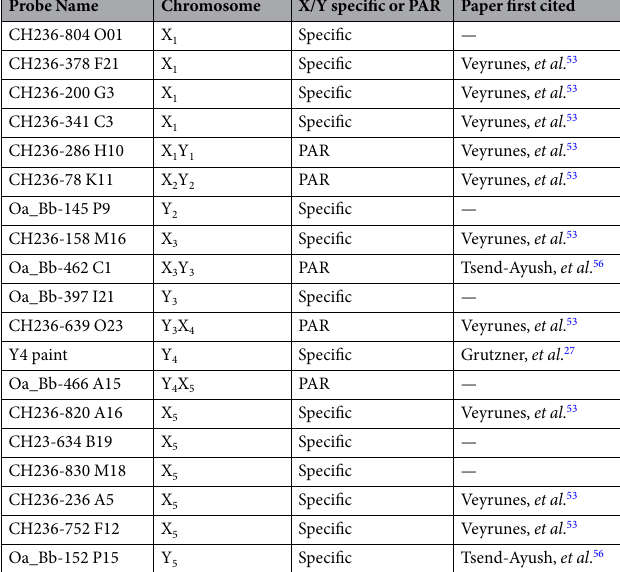
Differential SMC3 loading on paired and unpaired regions of platypus sex chromosomes at prophase I. To better characterise the sex chromosome specific SMC3 accumulations we immunostained for SMC3 in combination with DNA FISH using a selection of BACs and chromosome painting probes targeting XY specific and XY shared (PAR) regions. After SMC3 immunostaining, imaged cell coordinates were recorded prior to a series of DNA FISH experiments using combinations of X 1 pooled, X 4 , Y 5 and pooled PAR probes (Table 1). During early prophase I, the XY specific probes hybridised to chromosomal DNA which had axial ele- ment SMC3 but lacked a central element (SYCP1) (Fig. 7). At mid pachytene the XY specific probes colocalised with paranucleolar SMC3 but from diplotene associated with protein bodies or had no association with any SC